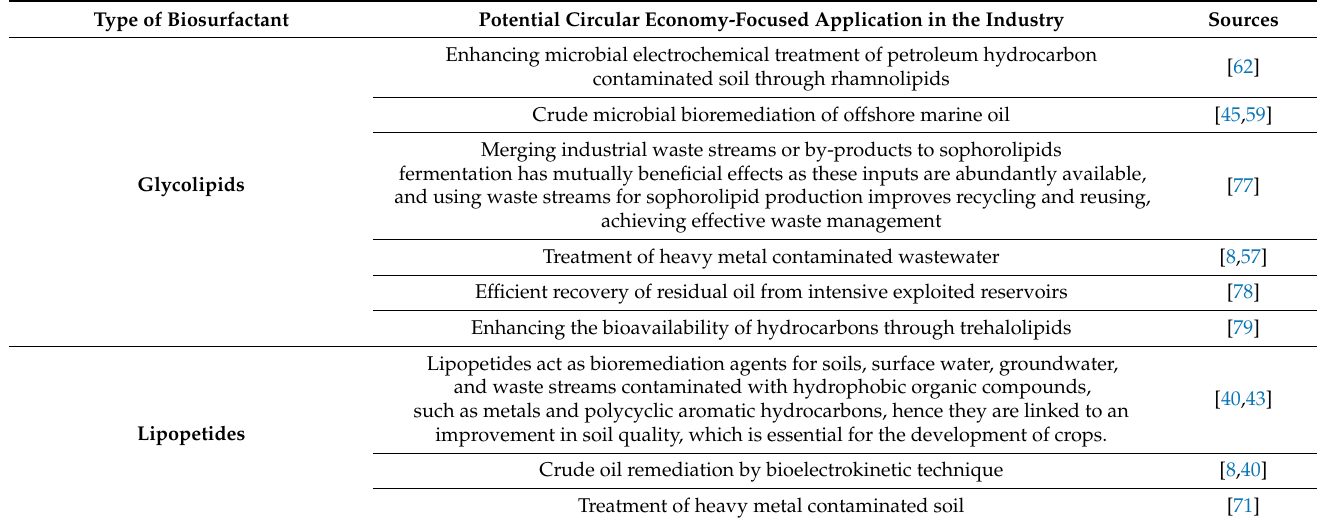
Table 3. Biosurfactants input to industry from a circular economy